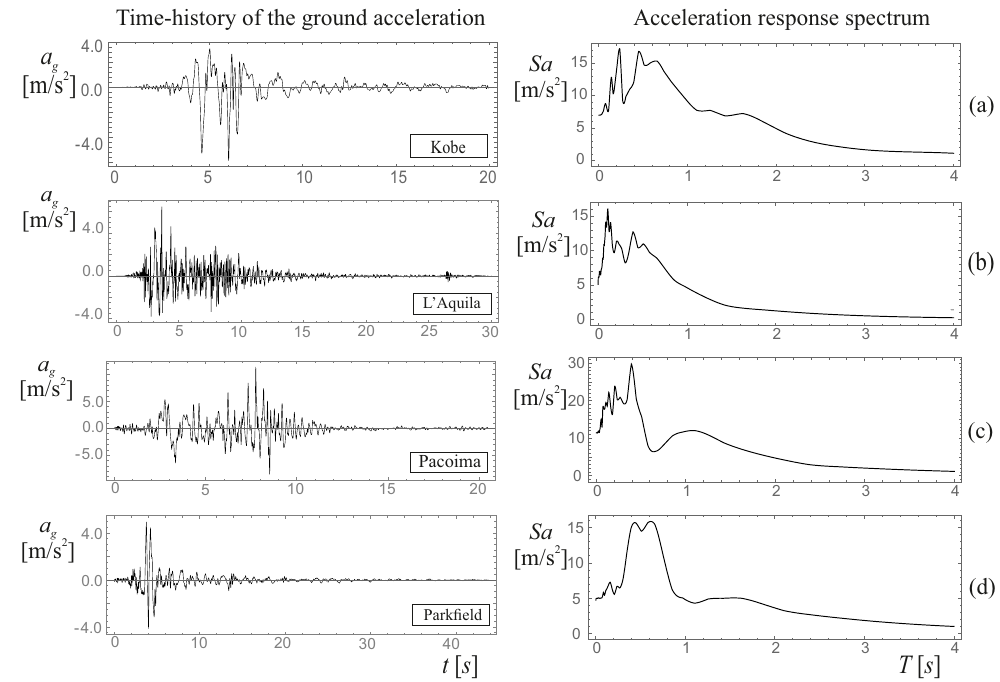
Figure 9. Time-histories and acceleration response spectra of the earthquakes analysed: ( a ) Kobe; ( b ) L’Aquila; ( c ) Pacoima; ( d )